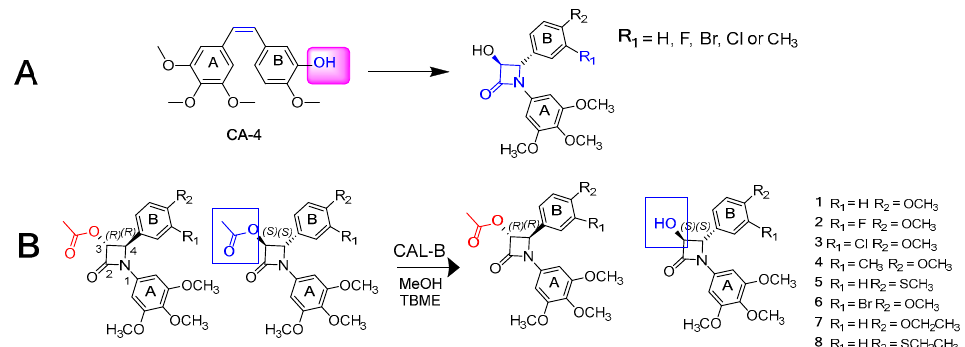
Figure 44. ( A ) Structural modifications to prevent cis/trans isomerisation of CA-4 and increase anti- proliferative activity in CA-4 resistant HT-29 cells; ( B ) CAL-B mediated methanolysis of 3-acetoxy to 3S,4S 3-hydroxyl enantiomers.